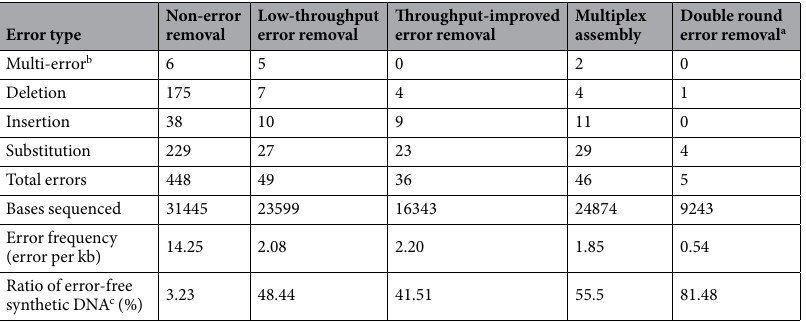
Table 1. Error analysis of assembled fragment sequences using different error-removal strategies with various throughputs a Error-removal was conducted both at oligo and fragment stages. b Error site located on sequence that contains more than three adjacent consecutive nucleotide errors. c Length of synthetic DNA was 319–423 bp for lycopene biosynthesis genes (without primer